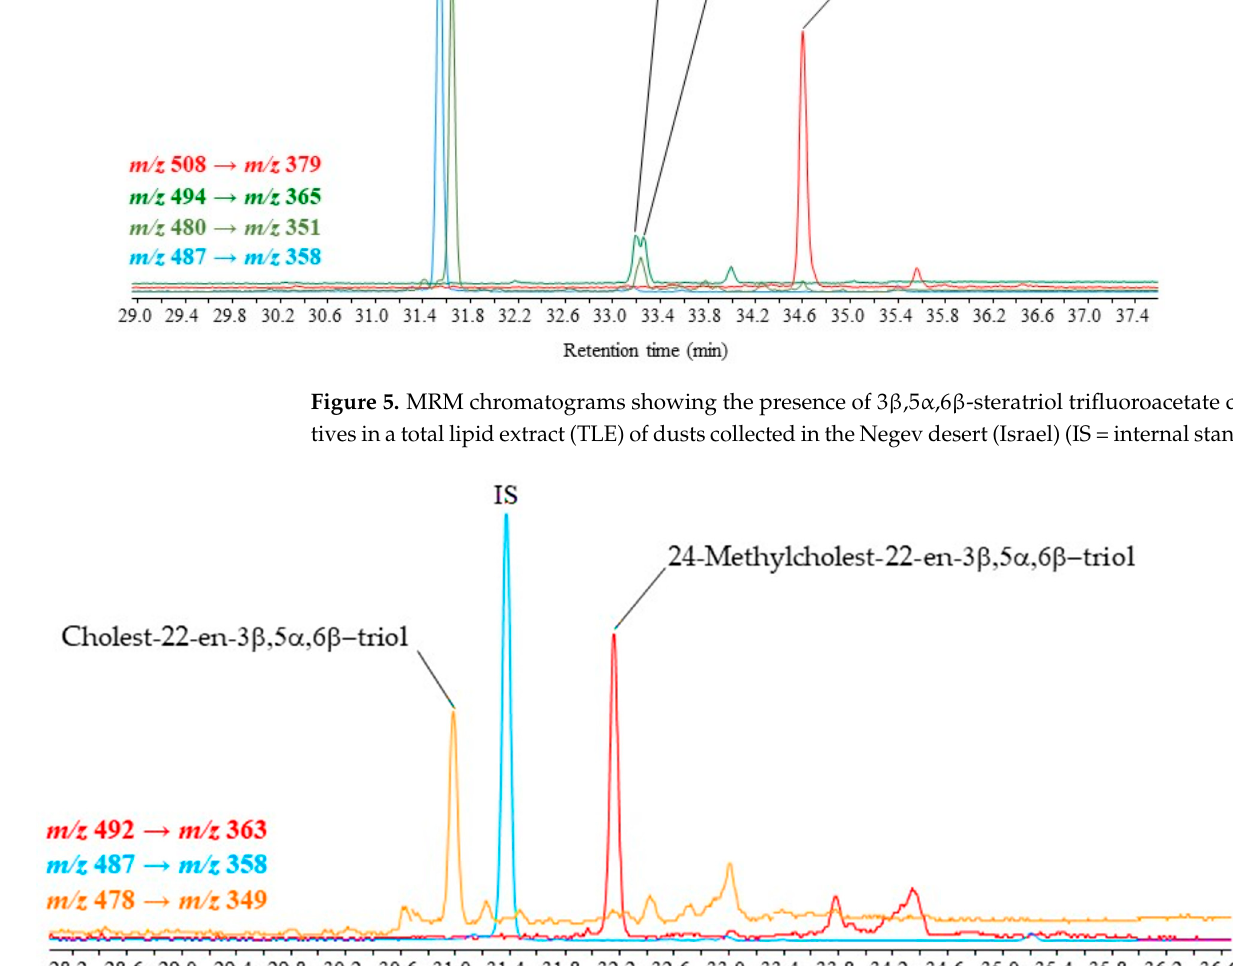
Figure 6. MRM chromatograms showing the presence of unsaturated 3 β ,5 α ,6 β -steratriol trifluoroac- etate derivatives in TLE of suspended particulate matter collected in the Amundsen Sea (Antarctica) (IS = internal standard).